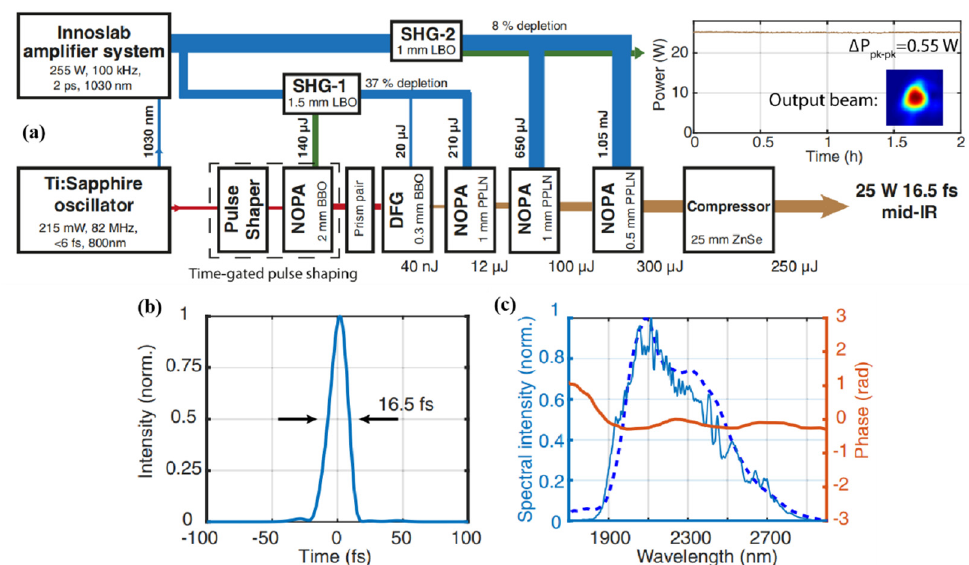
Figure 7. ( a ) 2.2 µ m OPCPA layout. The inset on the top right shows the long-term output stability of the system and beam profile after cylindrical reshaping telescopes. ( b ) The retrieved pulse shape of the amplifier output. ( c ) Blue line, measured spectrum; blue-dashed line, retrieved spectrum; orange line, retrieved phase. Reprinted with permission from [42].